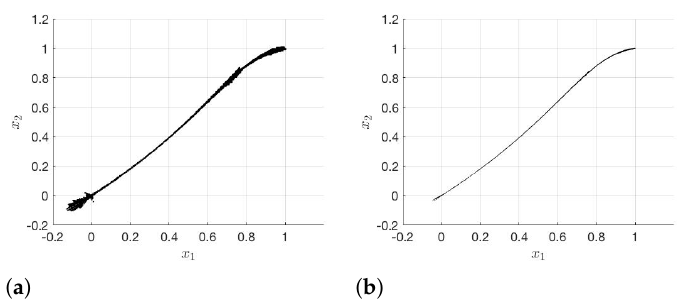
Figure 2. Pareto-critical set P c in iteration step ( a ) 20 and ( b ) 25 for the FE-solver. The results with the subdivision algorithm and RB-DEIM-solver are shown in Figure 3.